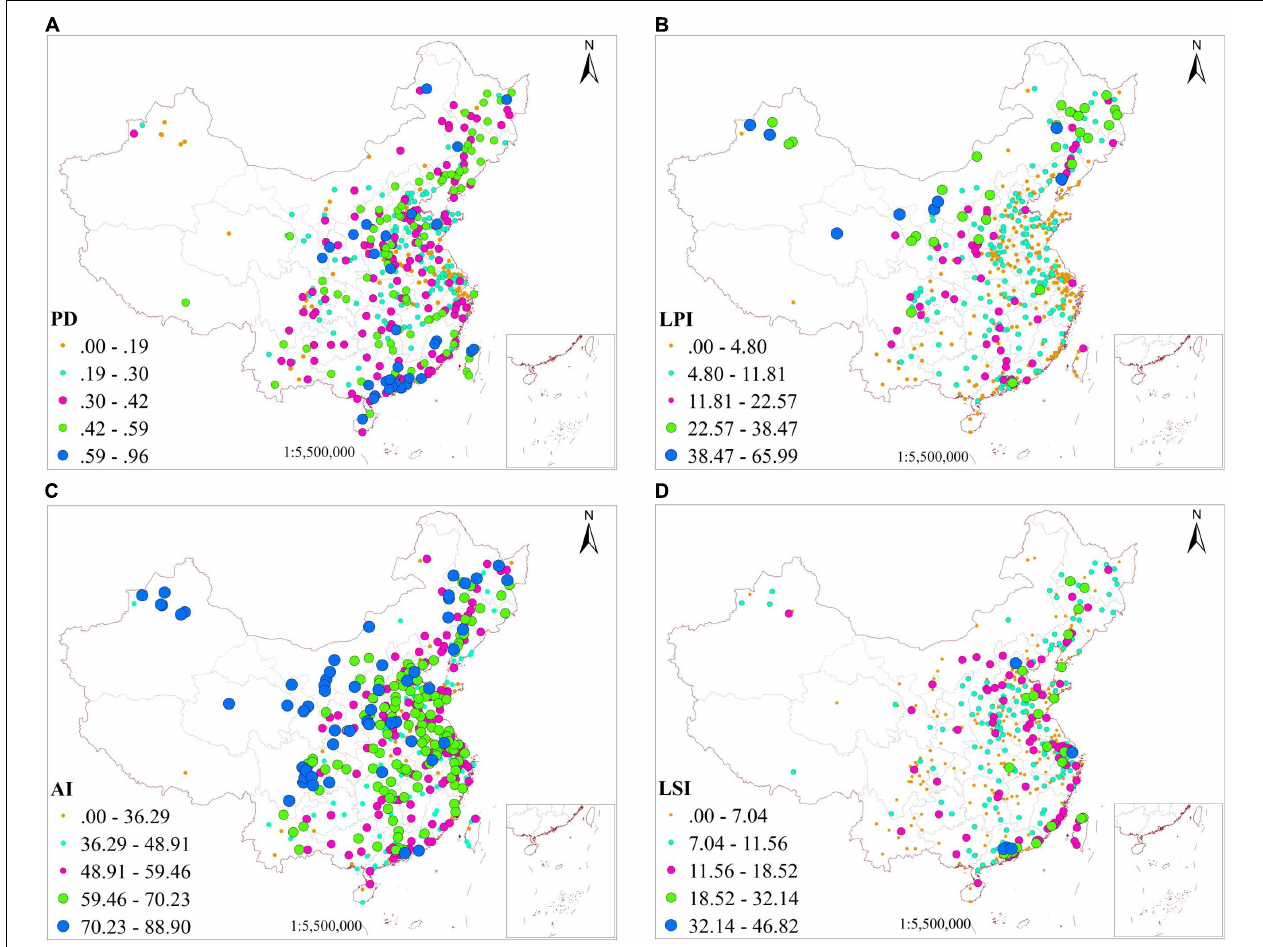
FIGURE 5 | Spatial variations in the landscape metrics for VG. (A–D) VG landscape metric for the PD, LPI, AI, and LSI,